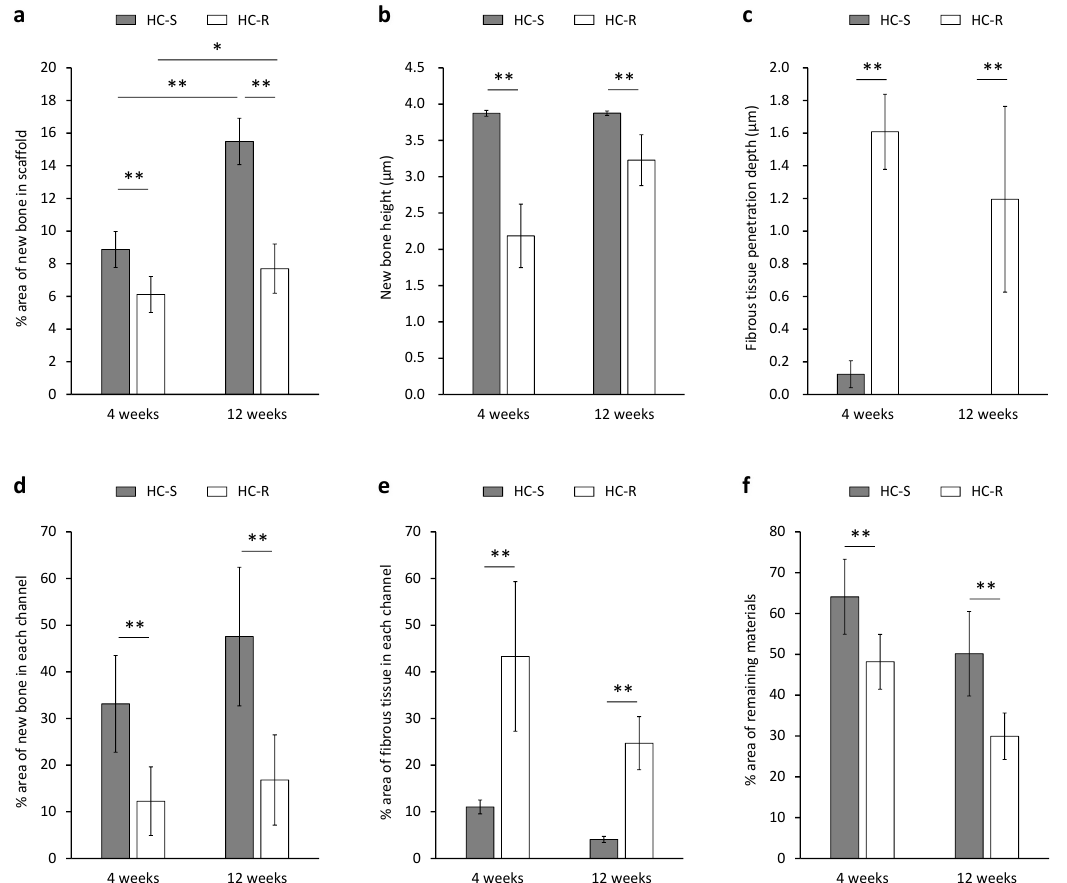
Figure 5. Area percentage ( a ) and height ( b ) of bone newly formed in honeycomb scaffolds with square channels (HC-S) and honeycomb scaffolds with rectangle channels (HC-R). The penetration depth of fibrous tissue from the scaffold top face ( c ). Area percentages of new bone ( d ) and fibrous tissues ( e ) in each channel of HC-S and HC-R. Area percentages of remaining materials in HC-S and HC-R ( f ). * p < 0.05 and ** p < 0.01. n = 5 per group.